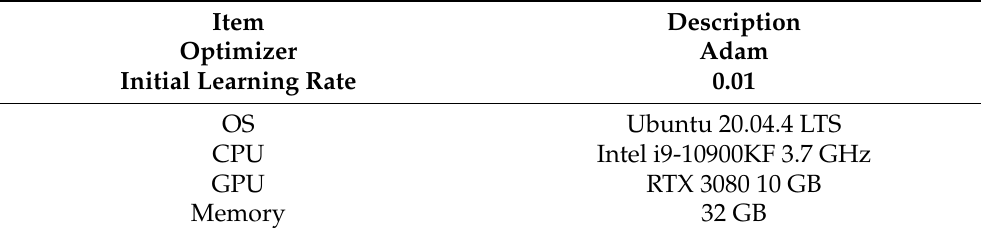
Table 6. Platform configuration for model training and prediction.